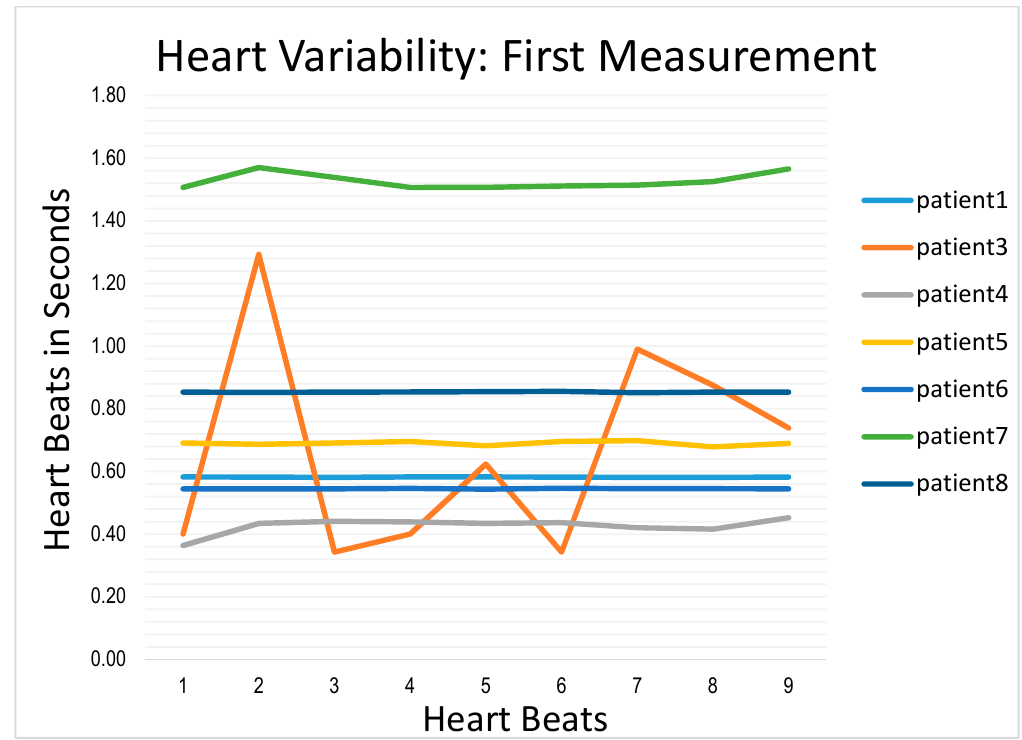
Figure 10. Heart Rate Variability results during the first measurement.